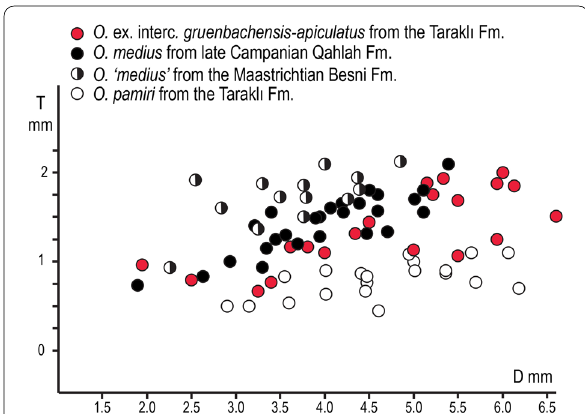
Fig. 11 Variation of test diameter ( D ) and thickness ( T ) in O. ex. interc. gruenbachensis Papp– apiculatus Schlumberger and O. pamiri Meriç from the Taraklı Formation and O. medius from the upper Campanian Qahlah Formation